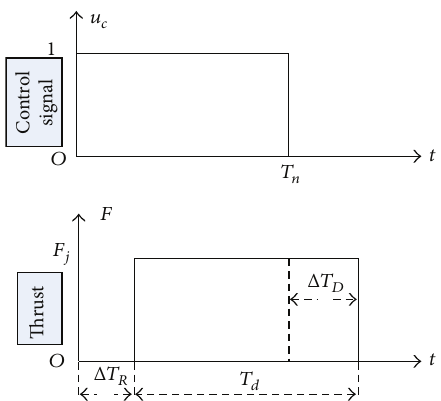
Figure 3: Thruster mathematical